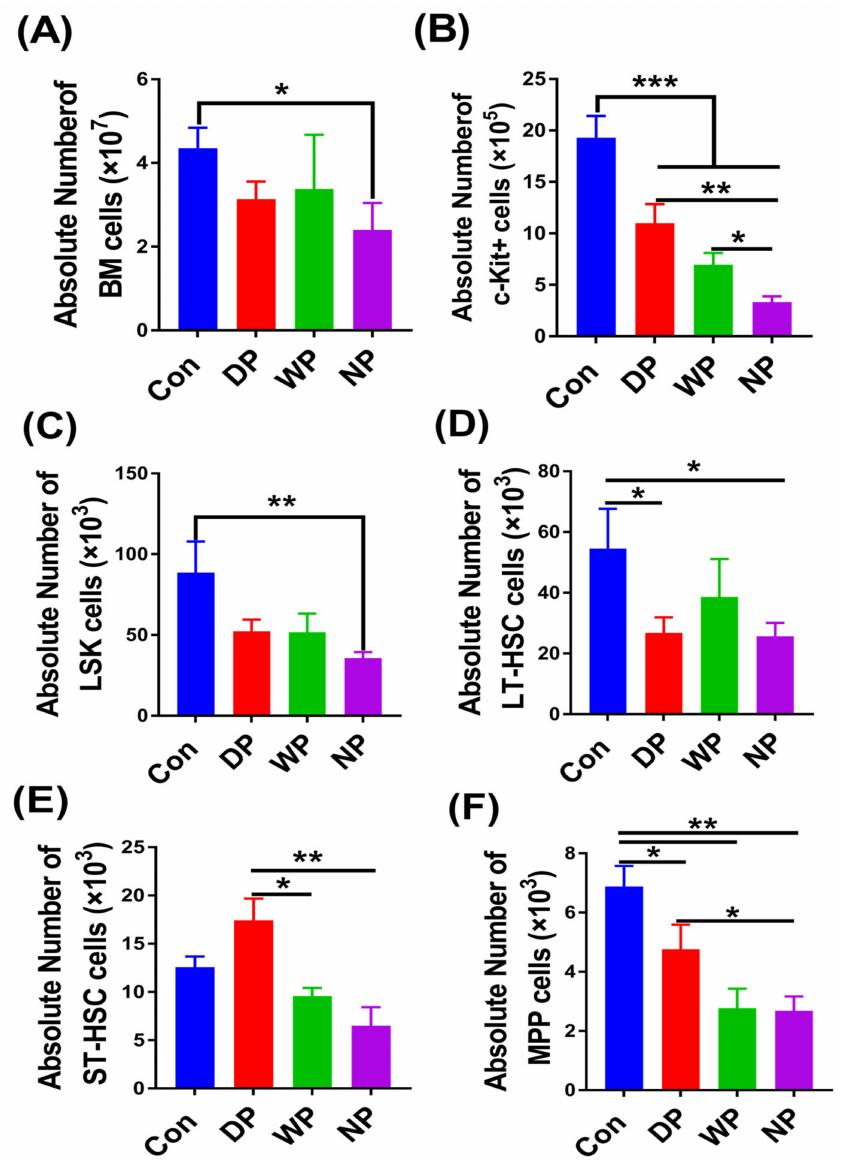
Figure 3. The absolute number of bone marrow cells and hematopoietic stem/progenitor cells (HS/PCs) on day 28 after BMT. Mice were euthanized, and bone marrow cells were har- vested for the cell count assay ( A ); simultaneously, the populations of c-kit cells (Lin-c-kit + ), LSK, LT-HSCs (Lin-Sca1 + c-kit + CD34 − Flk3 − ), ST-HSCs (Lin-Sca1 + c-kit + CD34 + Flk3 − ), MPPs (Lin- c-kit + Sca1 + CD34 + Flk3 + ) were analyzed with well-defined cell surface markers ( B – F ). Data are pre- sented as mean ± SEM ( n = 5–7). Results are representative of at least two independent experiments. *** p < 0.001, ** p < 0.01, * p <